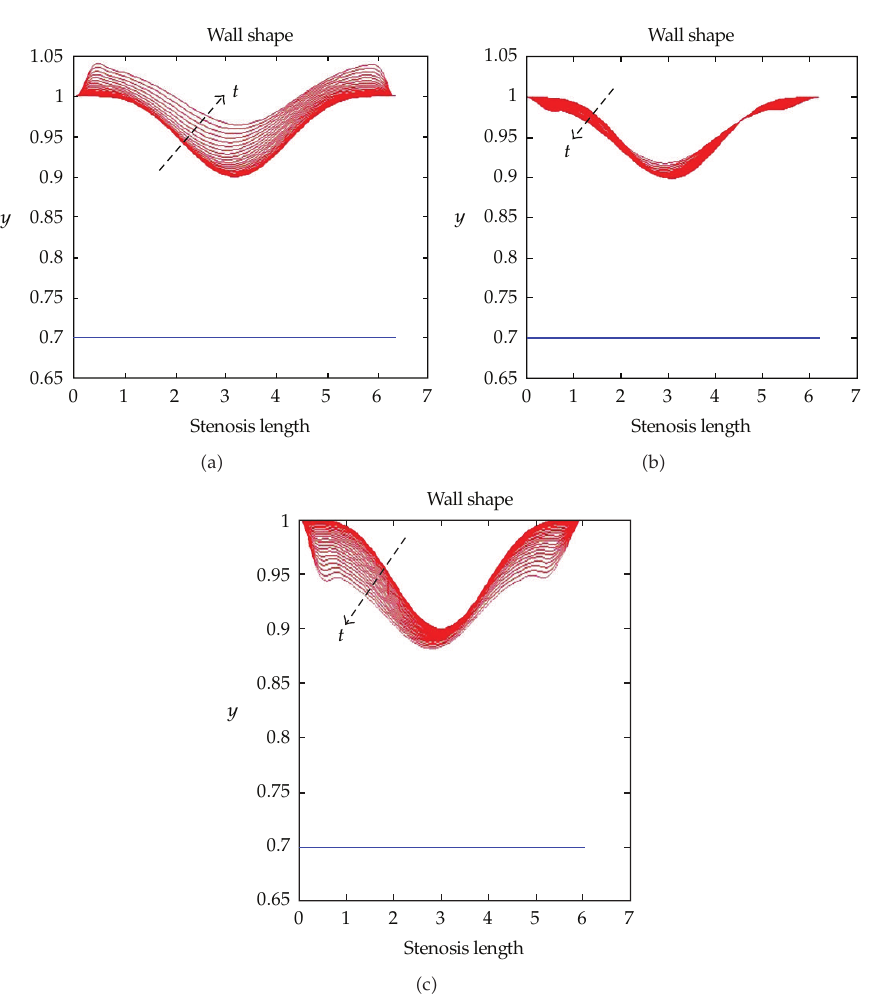
Figure 10: Predicted wall shape for wall thickness h (cid:7) 0 . 7mm (cid:3) a (cid:4) , 0.8mm (cid:3) b (cid:4) , and 0.9mm (cid:3) c (cid:4) .